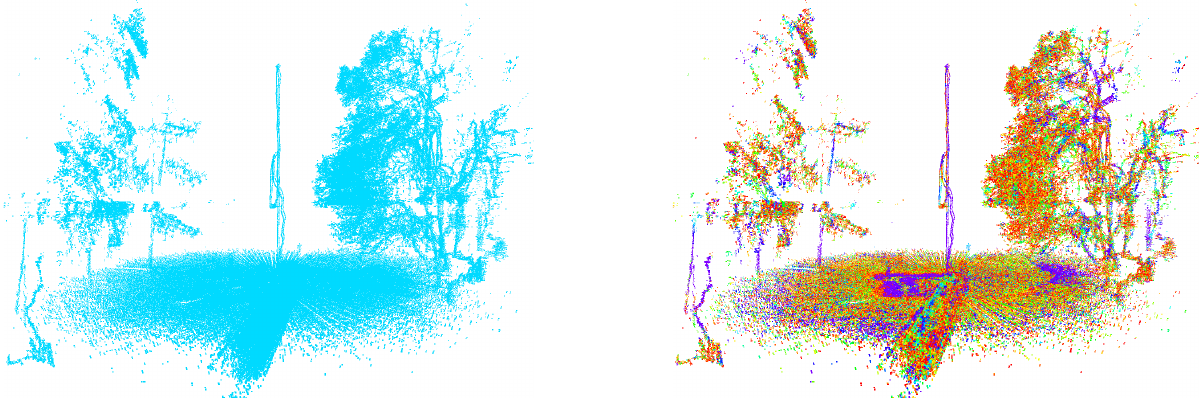
Figure 5. Visualization of the number of points within the local neighborhood when using the k = 50 nearest neighbors (left) and when using the k opt nearest neighbors selected via eigenentropy-based scale selection (right): the color encoding indicates neighborhoods with 10 or less points in red and reaches via yellow, green, cyan and blue to violet for 100 and more